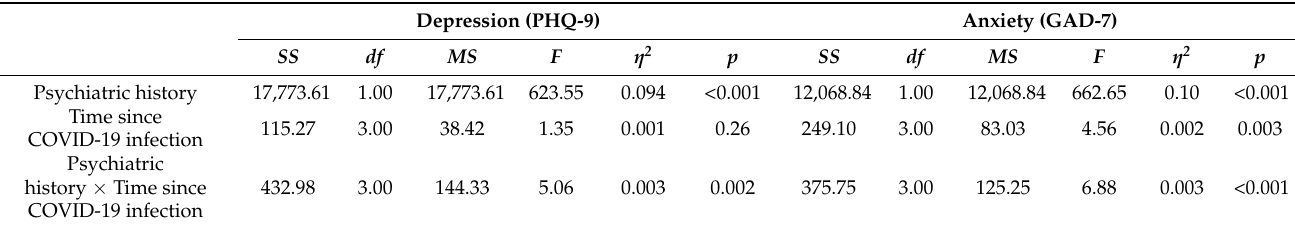
Table 2. Results of ANCOVA for Depression and